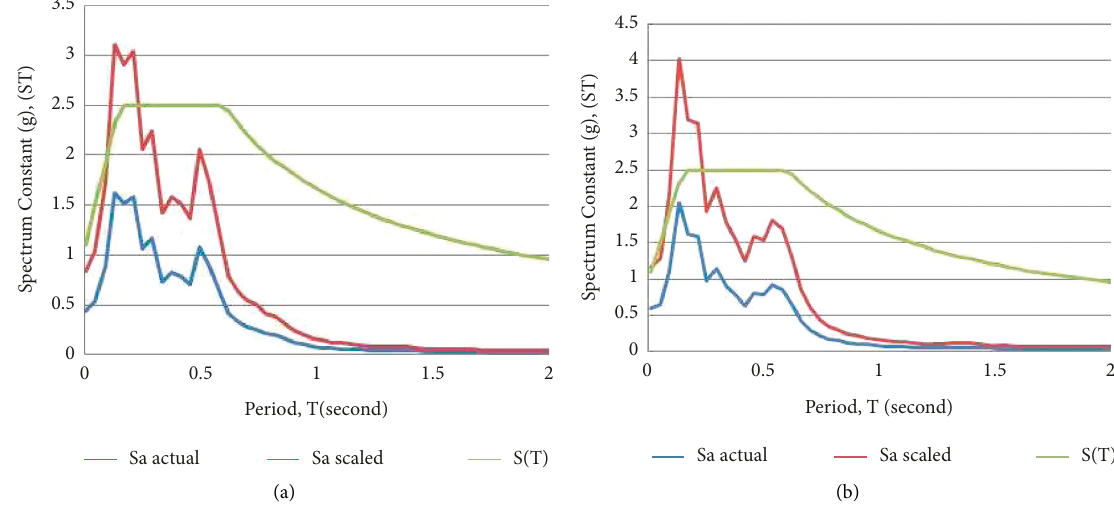
Figure 11: Evaluation of S(T) spectrum constants for (a) North-South (N-S) and (b) East-West (E-W) components of earthquake with epicenter at Sivas ( M D :